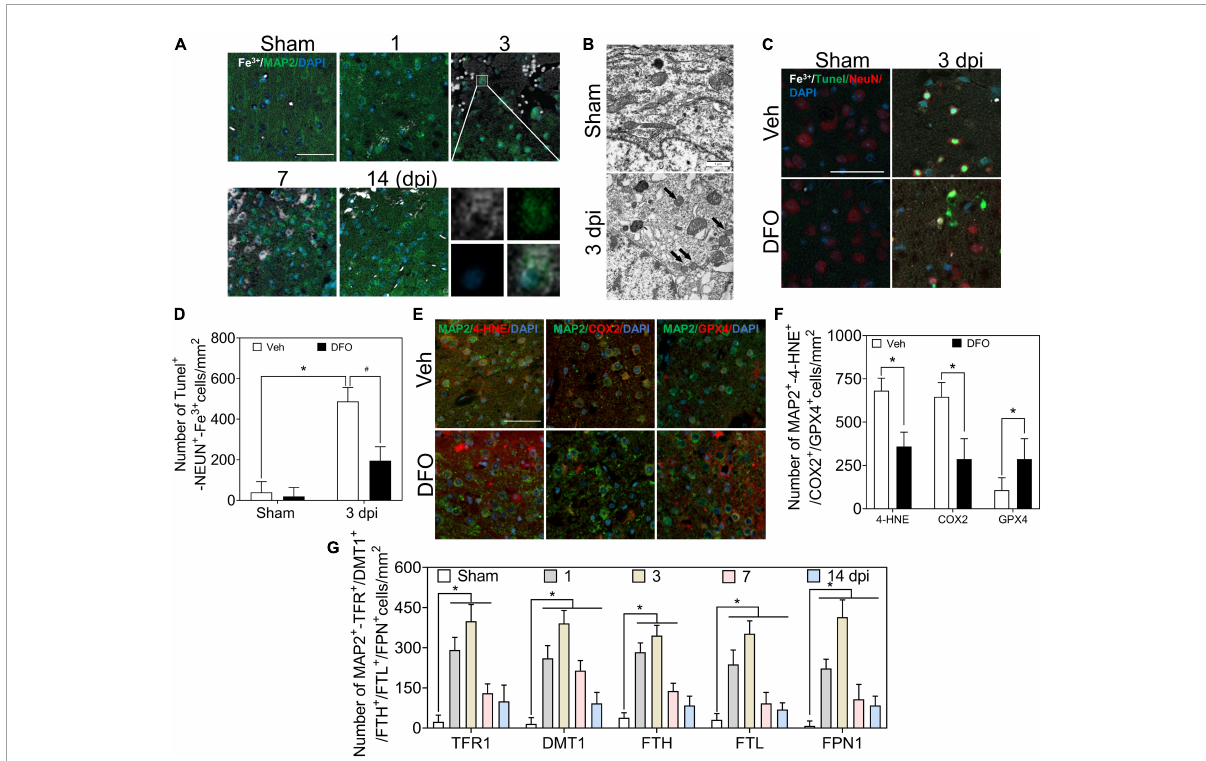
FIGURE2 Excessive iron and abnormal iron metabolism impair neurons after TBI. (A) Representative co-location image of Fe 3 + with MAP2 in ipsilateral cortices of mice at the indicated time after TBI ( n = 6, scale bar = 50 µ m). (B) Representative transmission electron microscopic images of neuronal mitochondria in ipsilateral cortices of mice in the Sham or TBI group. Shrunken mitochondria with dark density in damaged neurons are indicated by the black arrow at 3 dpi, and n = 6. (C) Representative colocation image of Fe 3 + , MAP2, and TUNEL in injured cortices of mice after 3 days treatment of Veh or DFO ( n = 3, scale bar = 50 µ m). (D) Quantitative analyses of the number of Tunel-NEUN-Fe 3 + -positive cells. Data are presented as mean ± SD. * p < 0.05 versus the Sham group, # p < 0.05 versus the Veh group. (E) Representative colocation image of 4-HNE, COX2, and GPX4 with MAP2 in injured cortices of mice after 3 days treatment of Veh or DFO ( n = 3, scale bar = 50 µ m). (F) Quantitative analysis of the number of 4-HNE/COX2/GPX4-MAP2-positive cells. Data are presented as mean ± SD, * p < 0.05 versus the Veh group. (G) Quantitative analysis of the number of TFR1/DMT1/FTH/FTL/FPN1-MAP2-positive cells in an ipsilateral injured cortex at the indicated time. Data are presented as mean ± SD, and n = 6. * p < 0.05 versus the Sham group. TBI, traumatic brain injury; MAP2, microtubule associated protein 2; DFO, deferoxamine; Veh, traumatic brain injury + vehicle; dpi, days post-injury; SD, standard deviation; 4-HNE, 4-hydroxynonenal; COX2, cyclooxygenase-2; GPX4, glutathione peroxidase 4; TFR1, transferrin R1; DMT1, divalent metal transporter 1; FTH, ferritin heavy chain; FTL, ferritin light chain; FPN1,